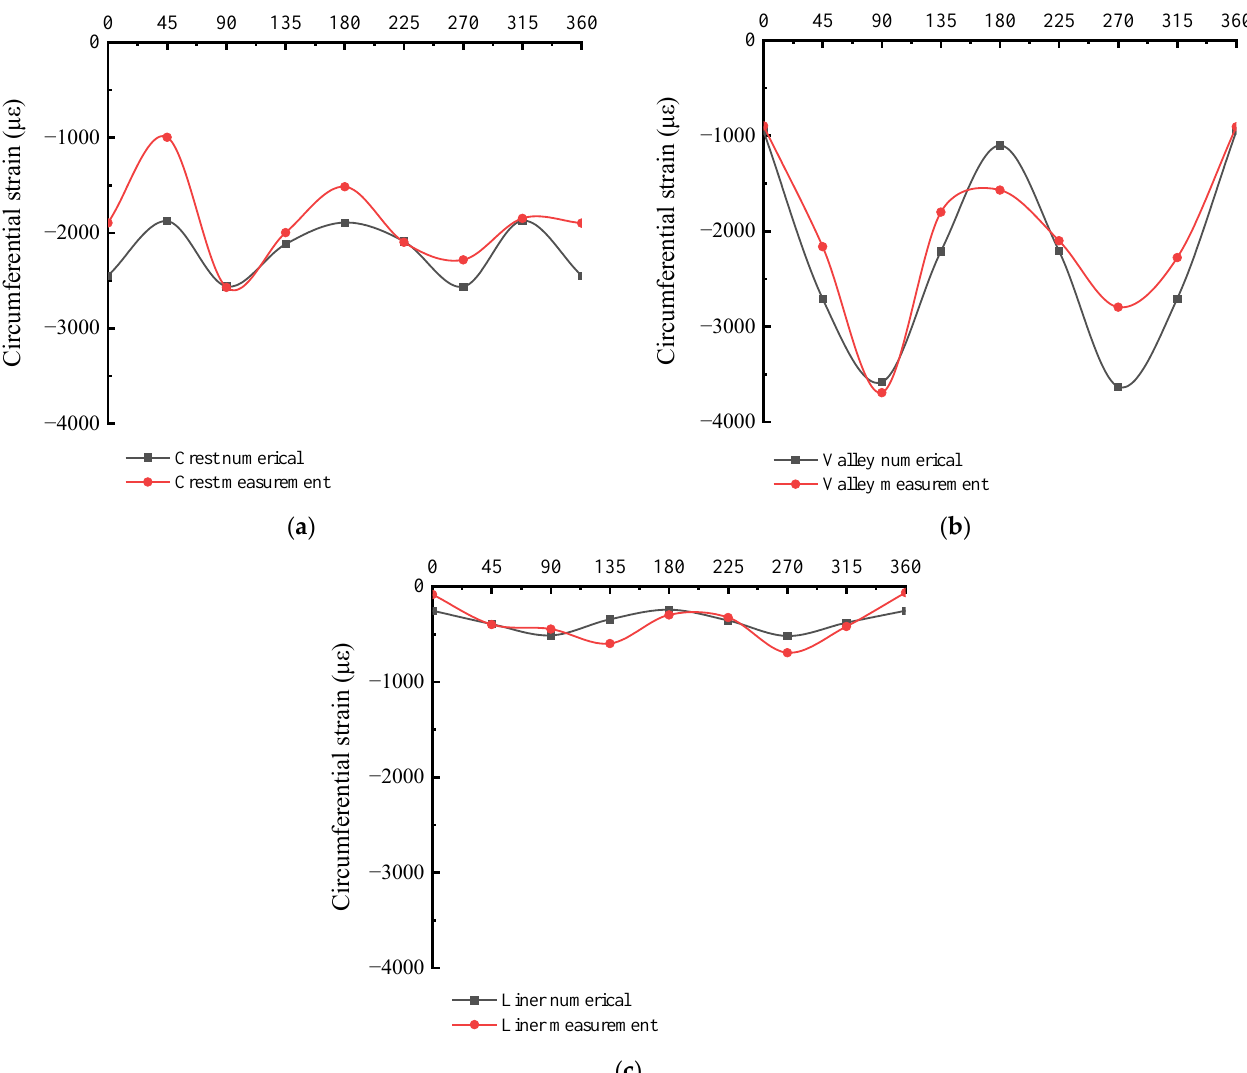
Figure 10. Circumferential detection and position of pipes.